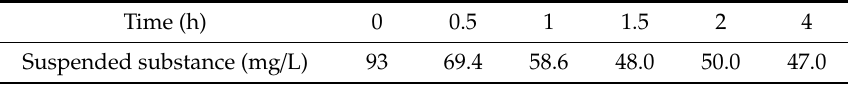
Figure 1. Demulsification e ffi ciency of potassium ferrate under di ff erent conditions of ( a ) pH value, ( b ) temperature, ( c ), the addition of potassium ferrate, and ( d ) presence and absence of potassium ferrate. Table 1. The suspended substance content of fracturing wastewater for di ff erent